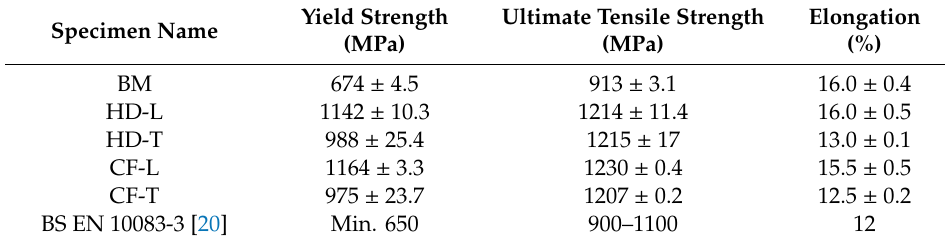
Table 2. Tensile properties with average ± standard deviation.